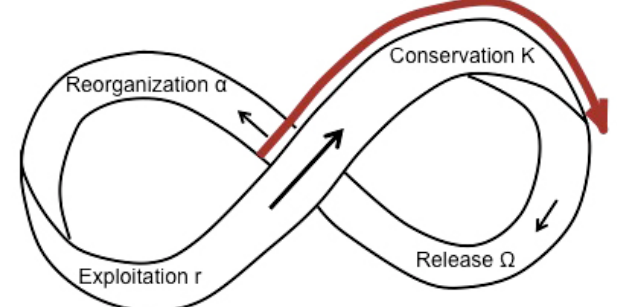
Fig. 3 . Overlay of farmers’ narrative onto the adaptive cycle. of the adaptive cycle approaching collapse between K and